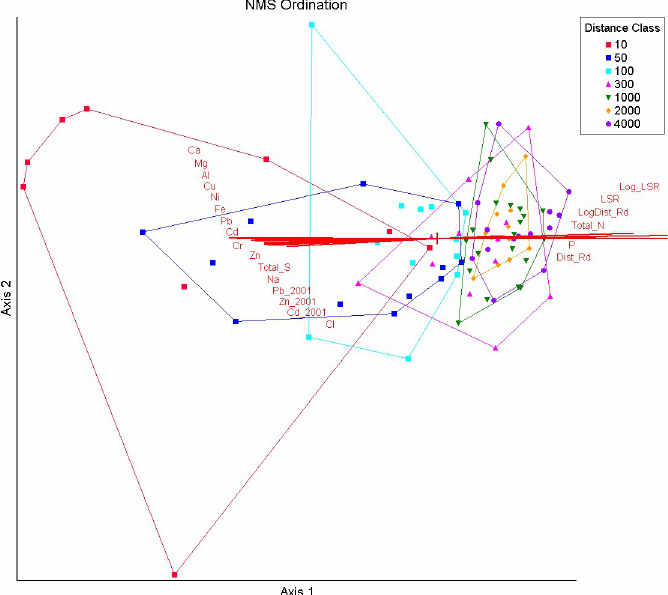
Fig 4. Nonmetric multidimensional scaling ordination of lichen plots at distances 10 m through 4000 m from the DMTS haul road in Cape Krusenstern National Monument, Alaska. The ordination is overlain by vectors proportional to the strength of their correlation with ordination axes. Spearman r values for each variable are provided in Table 2. Convex hulls surround plots in each distance class. All two letter abbreviations are elements. Mean elemental values in the data were mg/kg in Hylocomium splendens tissue, dry weight, except % Total S and % Total N. Other abbreviations are: Total_S (total sulfur), LSR (lichen species richness), LogDist_Rd (log 10 distance to the haul road), Total_N (total nitrogen), P (phosphorus), Dist_Rd (distance to the haul